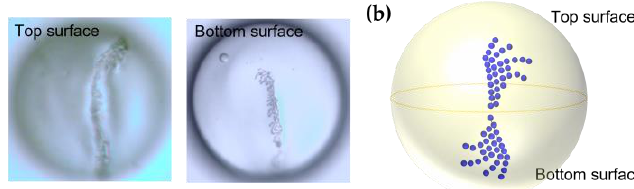
Figure 5. The geometry of the laser-processed CLC droplet in Figure 4. ( a ) By adjusting the focus of the microscope, a quill-like ND assembly near the top and bottom surface of the CLC droplets was observed. ( b ) The schematic drawing for the distribution in the host CLC droplet.